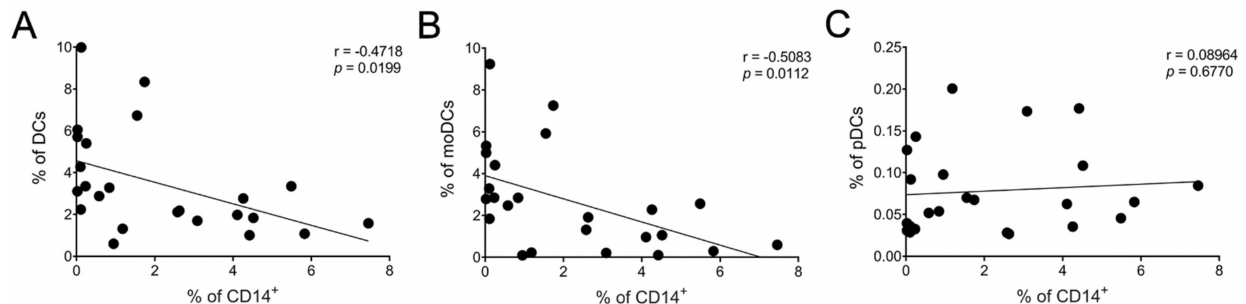
Figure 6. Association between reduced CD14+ cells and increased DC populations. Correlation between CD14 + cells and DC subsets: ( A ) total DCs, ( B ) moDCs, and ( C ) pDCs after 24 h of LSF (10 µ M and 50 µ M) treatment. Each datapoint is an individual sample across each of the three groups ( n = 8/group). A Pearson’s correlation was performed. Abbreviation: CD, cluster of differentiation; DC, dendritic cell, LSF, L-sulforaphane; moDC, monocyte-derived dendritic cell; pDC, plasmacytoid dendritic cells.